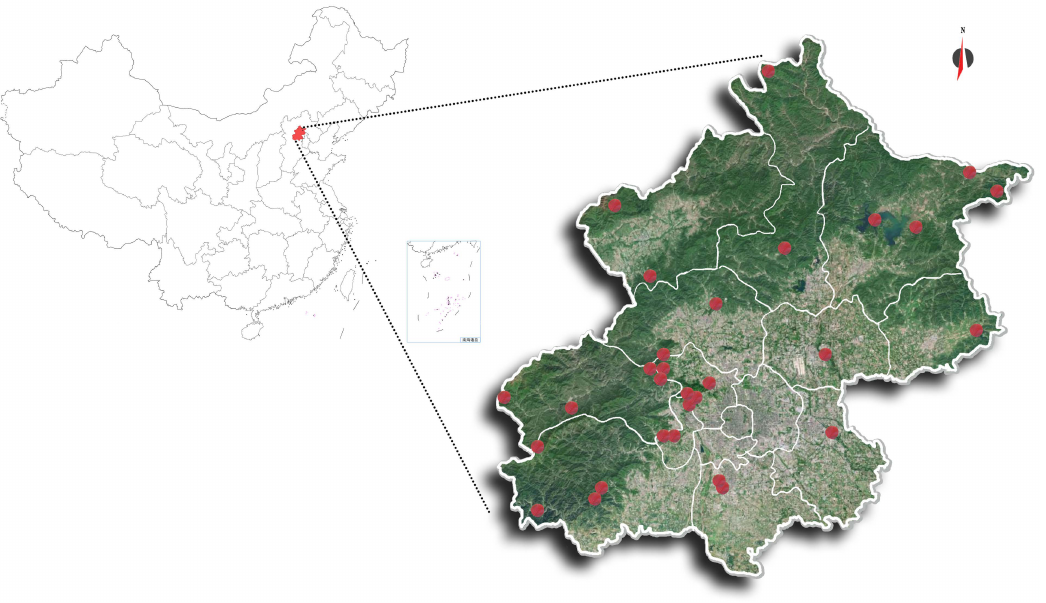
Figure 1. Relief map of Beijing. Red dots represent the sites where Cotinus coggygria var. cinerea Engl. were planted. Table 1. Main sites to plant Cotinus coggygria var. cinerea Engl. forest in Beijing.